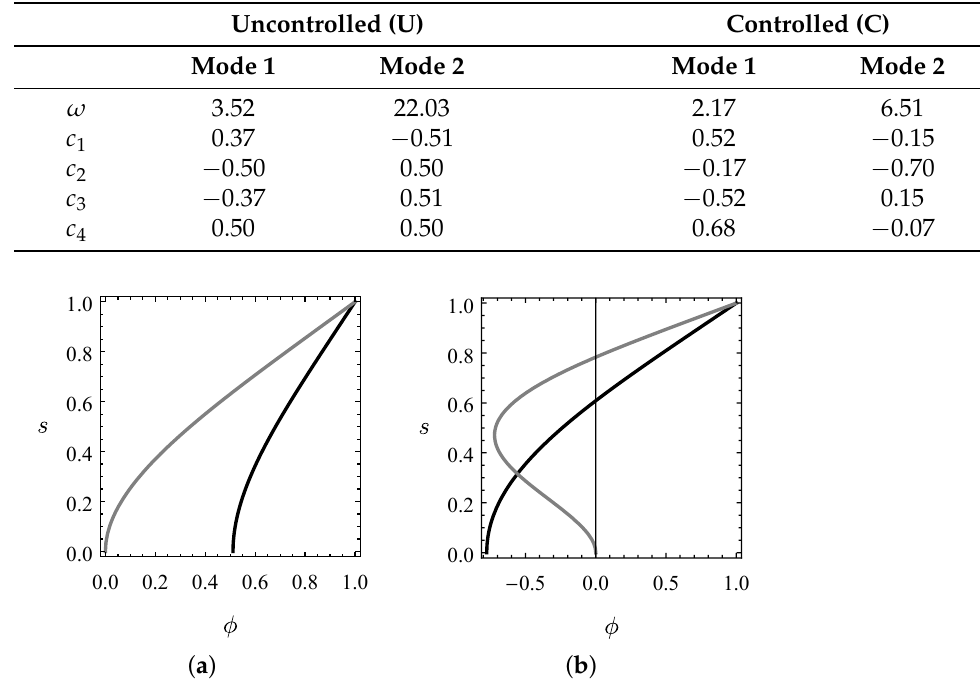
Figure 3. ( a ) First natural mode; ( b ) Second natural mode. Gray and black lines indicate the uncon- trolled and controlled system, respectively. Internally resonant case for κ =